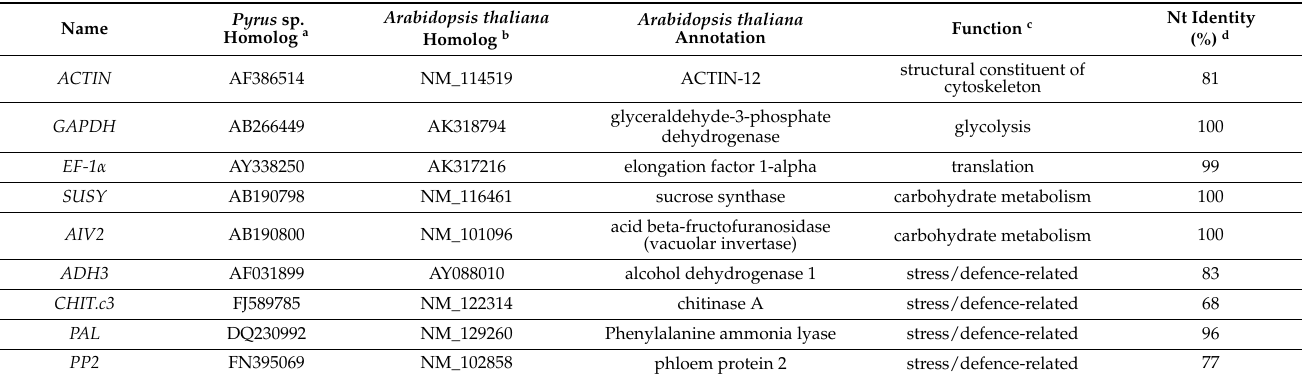
Table 2. Description of Pyrus. sp. housekeeping genes ( ACTIN, EF-1 α and GAPDH ), carbohydrate metabolism genes ( SUSY and AIV2 ) and stress/defence-related genes ( ADH3 , PAL , CHIT.c3 and PP2 ) selected for qPCR